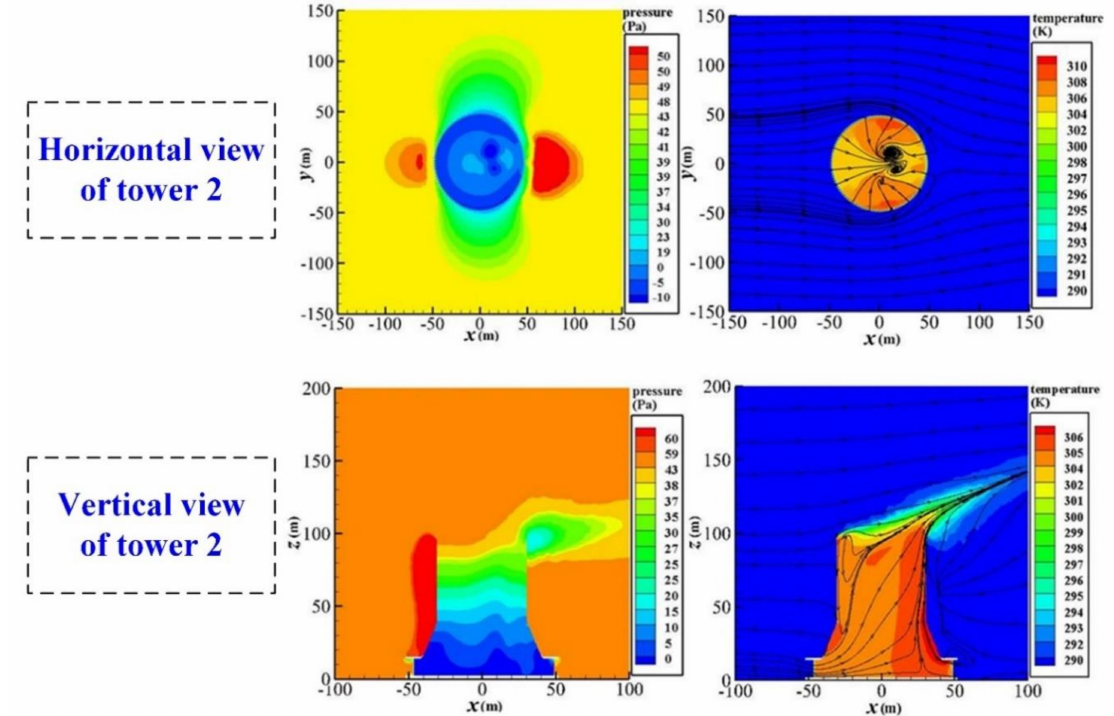
Figure 11. Air variable contours for steel-truss NDDCS with conical/cylindrical tower configuration at design crosswind of 4